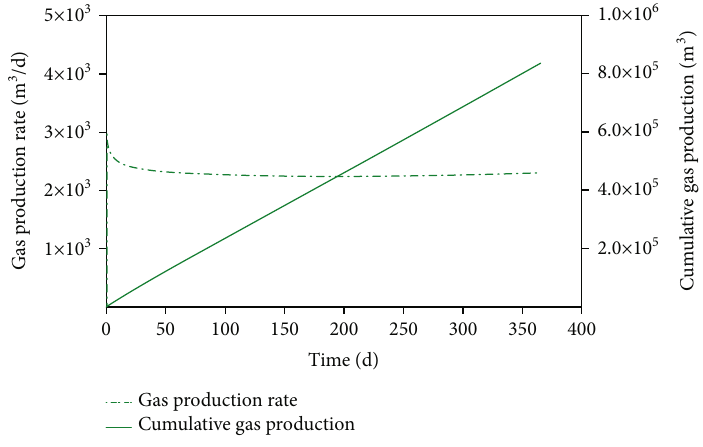
Figure 9: Performance of gas production.